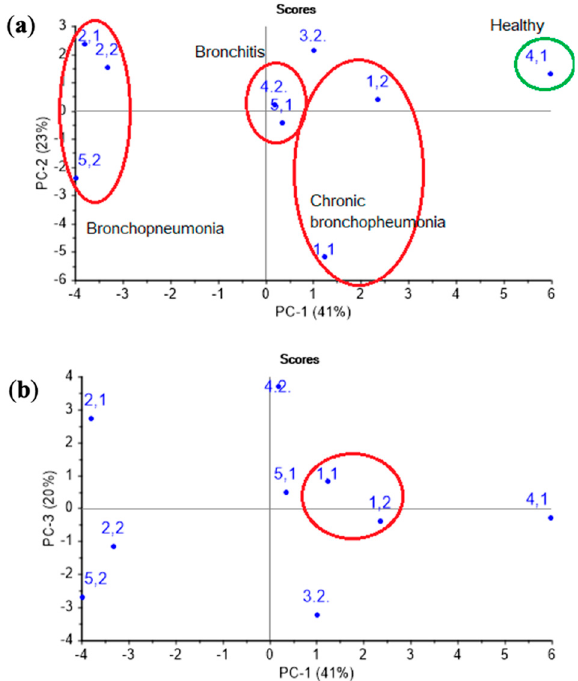
Figure 6. The ( a ) PC1 vs. PC2 and ( b ) PC1 vs. PC3 PCA score plots of nasal swabs of calves’ sam- ples.